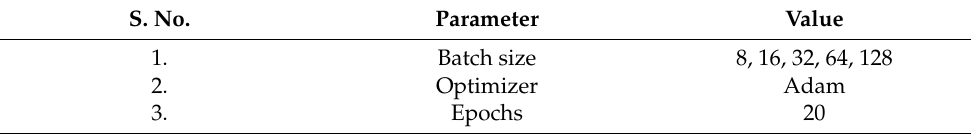
Table 5. Hyper Tuning Parameters. S. No. Parameter Value 1. Batch size 8, 16, 32, 64, 128 2. Optimizer Adam 3. Epochs